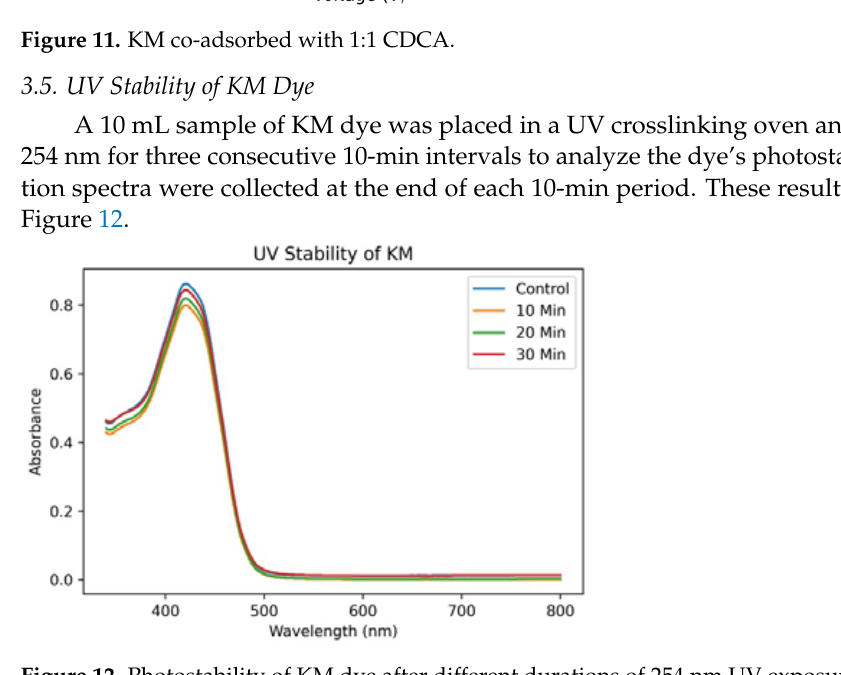
Figure 12. Photostability of KM dye after different durations of 254 nm UV exposure.